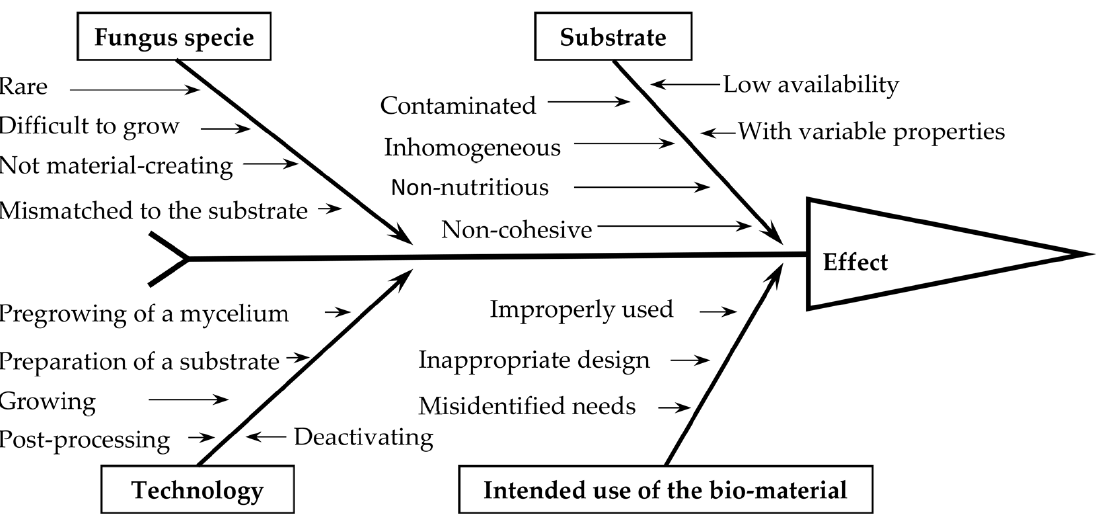
Figure 6. Factors affecting the manufacture and use of Mycelium-Based Composites.